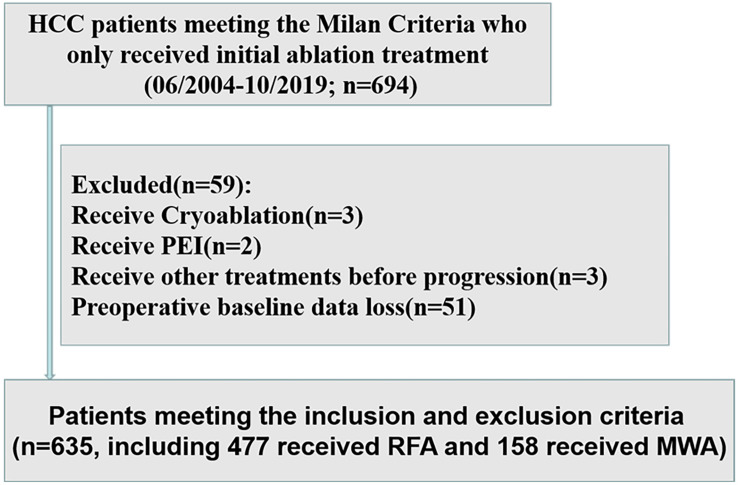
Flow diagram of the study design. HCC, hepatocellular carcinoma; PEI, percutaneous ethanol injection; MWA, microwave ablation; RFA, radiofrequency ablation.